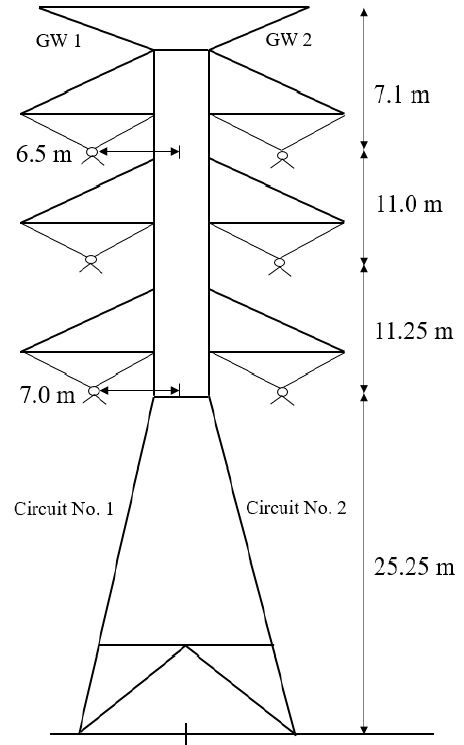
Figure 1. Structure of a tower for 500 kV line.